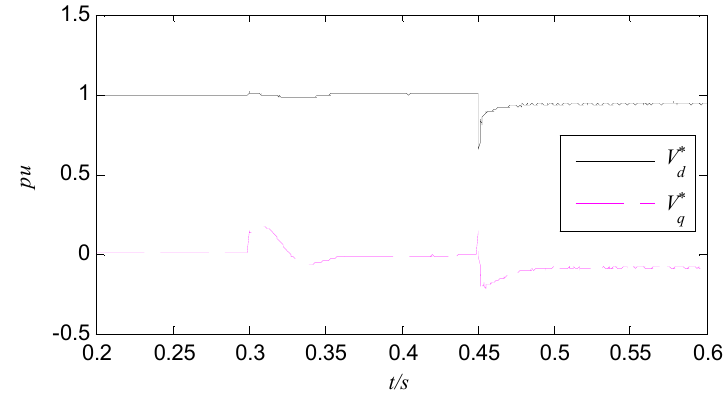
Figure 12. The controller output during micro ‐ grid switches to grid ‐ connected mode.